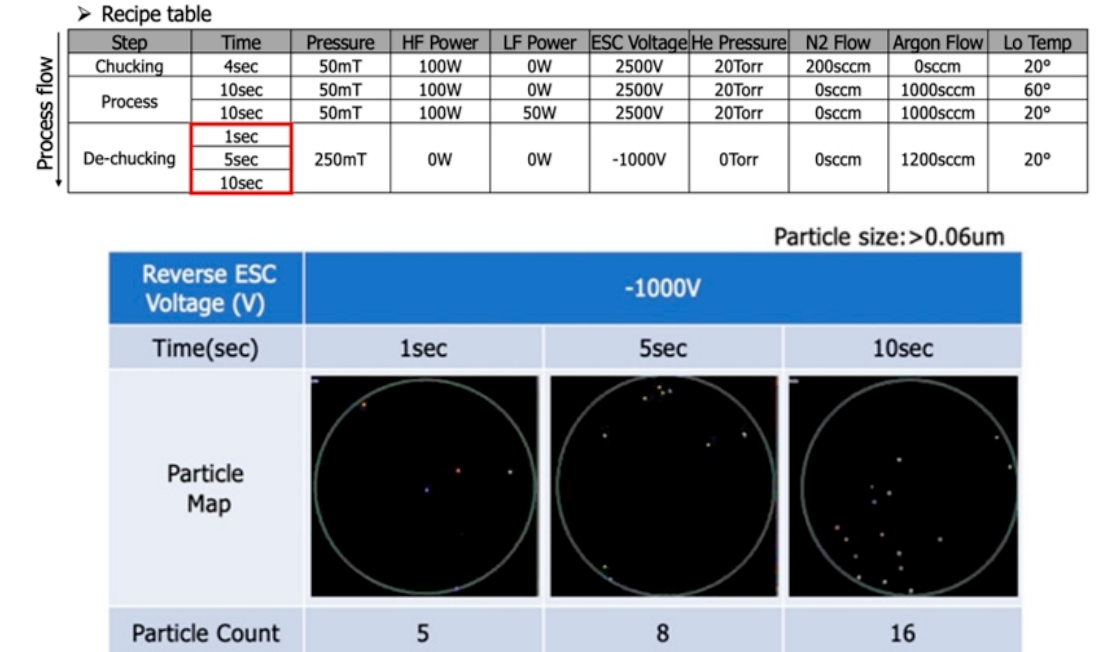
Figure 19. Particle deposition results under different application times for an ESC reverse voltage.